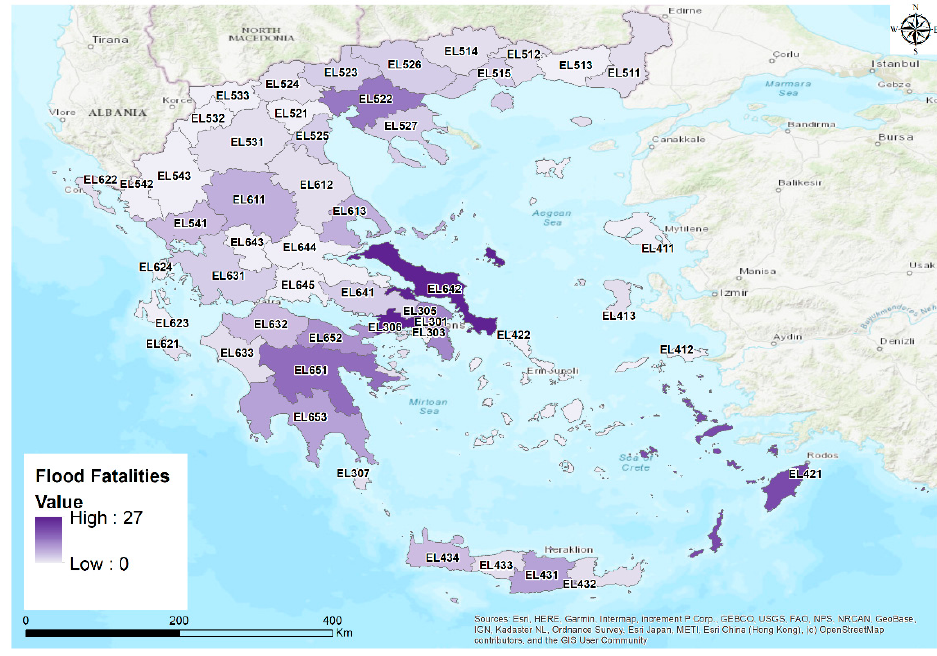
Figure 4. Spatial destitution of flood fatalities at the NUTS 3 level over Greece.